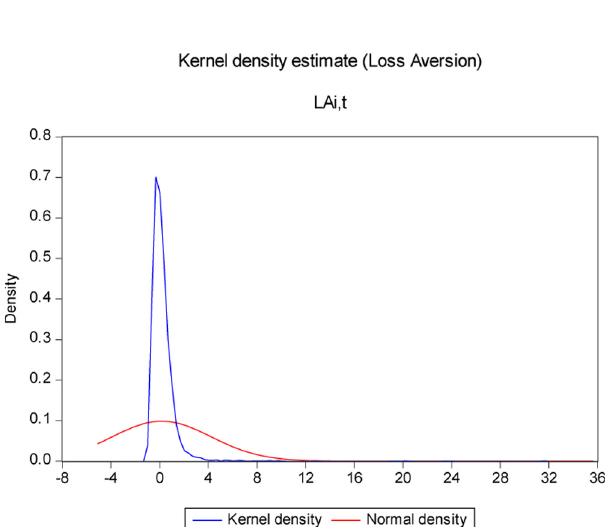
Figure 3. Non-normality of loss aversion (service sector)